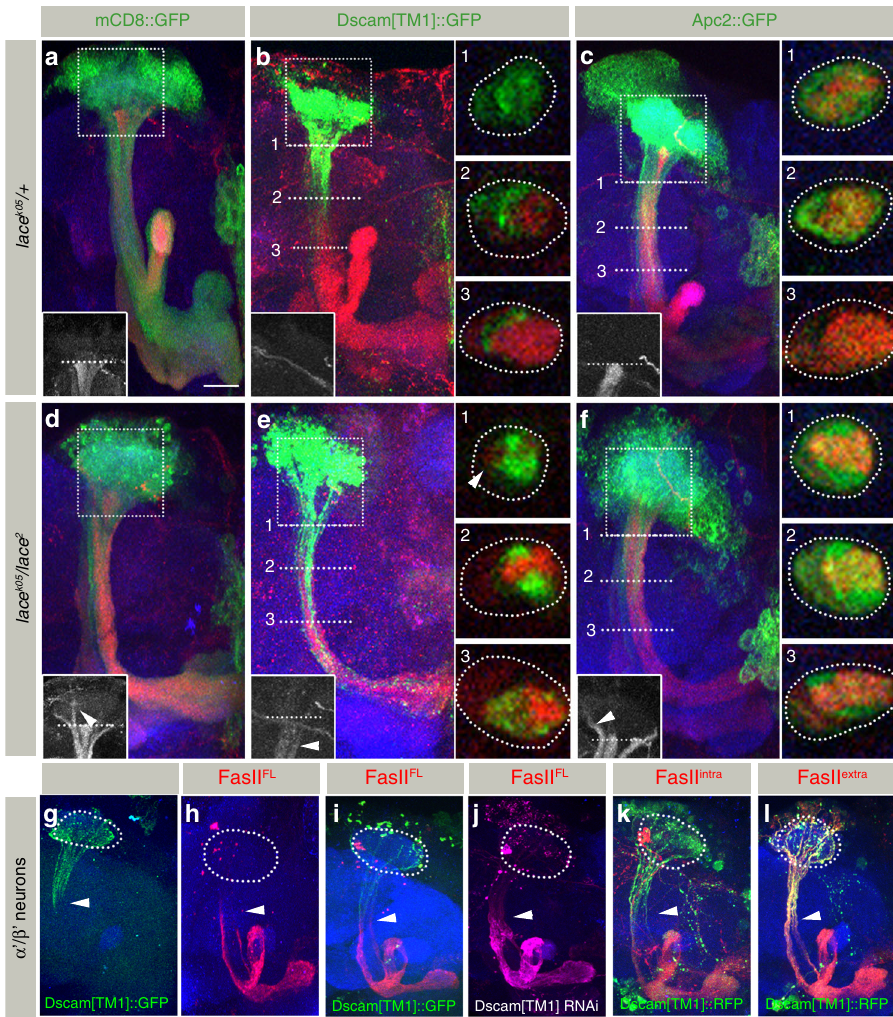
Fig. 6 Dscam[TM1]-FasII interaction de fi nes axonal versus dendritic domain in MB neuron. a – f MB of lace k05 / + ( a – c ) and lace 2 /lace k05 ( d – f ) labeled for FasII with mCD8::GFP ( a , d ), Dscam[TM1]::GFP ( b , e ) or Apc2::GFP ( c , f ) expressed using OK107-Gal4 . Inset represents FasII distribution from the area indicated by the dotted box. White dotted lines 1-3 in b , c , e , f represent three peduncular zones for analysis and the corresponding cross section of the peduncle (from a different image) is represented in the insets 1-3. In SPT mutants, membranous FasII shifts upwards into the dendritic compartment (inset ( d ), arrowhead). The expression of Dscam[TM1]::GFP causes axo-dendritic boundary of FasII to shift deeper into the peduncle, while retaining the exclusion from Dscam[TM1]::GFP ( b ). FasII partially regains its axo-dendritic boundary in SPT mutants owing to absence of membranous Dscam[TM1] (( e ), arrowhead insets). Expression of the cytosolic dendritic marker Apc2::GFP causes no shift in FasII localization ( c , f ). g – l MB in the wild-type background with α ′ / β ′ neuron-speci fi c expression (R26E01-Gal4) of Dscam[TM1]::GFP ( g ), FasII PEST − ( h ), Dscam[TM1]::GFP + FasII PEST- ( i ), Dscam [TM1]::RNAi + FasII PEST − ( j ), Dscam[TM1]::RFP + intra-FasII-YFP ( k ), and Dscam[TM1]::RFP + extra-FasII-YFP ( l ). Full length (FL) FasII and Dscam[TM1] maintains exclusion in α ′ / β ′ neurons ( g – i ). Interestingly, Dscam[TM1] knockdown causes FasII to shift into the somato-dendritic compartment ( j ). On the other hand, intra-FasII-YFP ( k ) but not extra-FasII-YFP ( l ) shows membranous exclusion from Dscam[TM1], indicating that the membranous exclusion is mediated by interactions in the intra-cellular domain. The white arrowhead marks the axo-dendritic boundary, the white dotted circle marks calyx. n ( g ) = 28, n ( h ) = 40, n ( i ) = 24, n ( j ) = 36, n ( k ) = 28, n ( l ) = 28. a – l Green: GFP, Red: FasII, Blue: N-Cad, Scale Bar: 25 μ